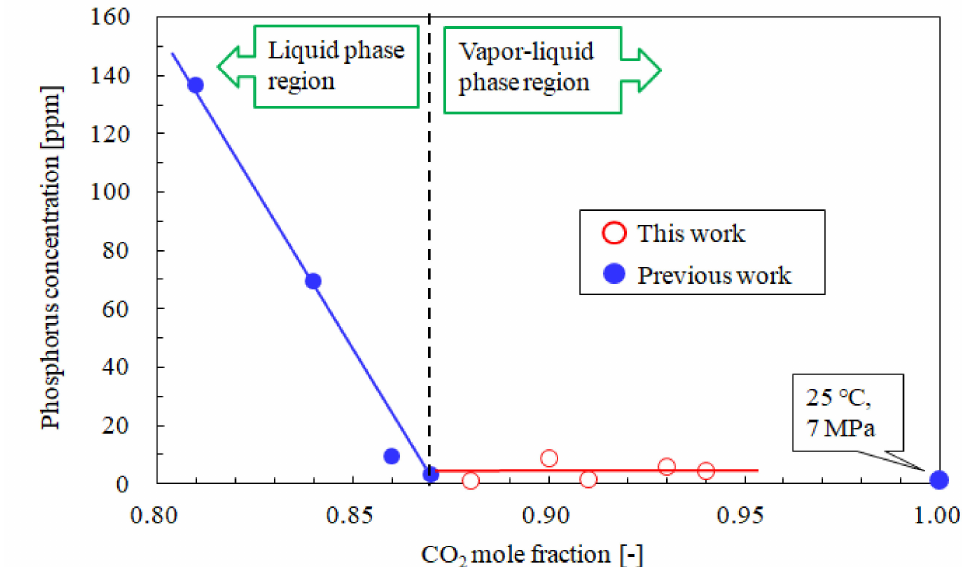
Figure 9. Relationship between the phosphorus concentration in the extracted oil and CO 2 mole fraction in CO 2 -expanded hexane in liquid phase region and vapor-liquid phase region at 25–26 ◦ C and 5.0–5.2 MPa, in addition to that of liquid CO 2 at 25 ◦ C and 7 MPa. Previous work is shown in ref.